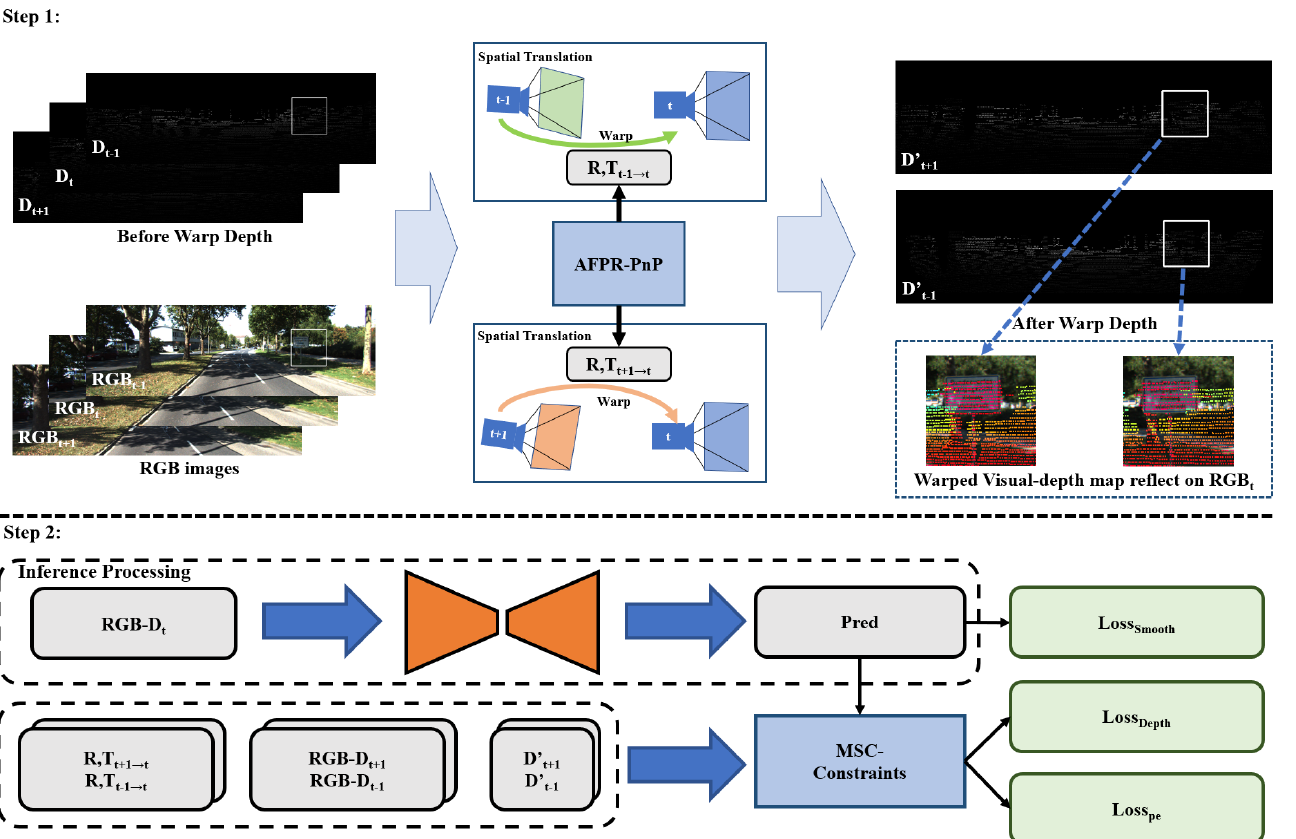
Figure 1. The framework of the proposed self − supervised depth completion network, step 1: spatial translation for preprocessing; step 2, self − supervised training. Gray rectangles are variables, orange is the inference network, blue is computational modules (no parameters to learn), and green is the loss